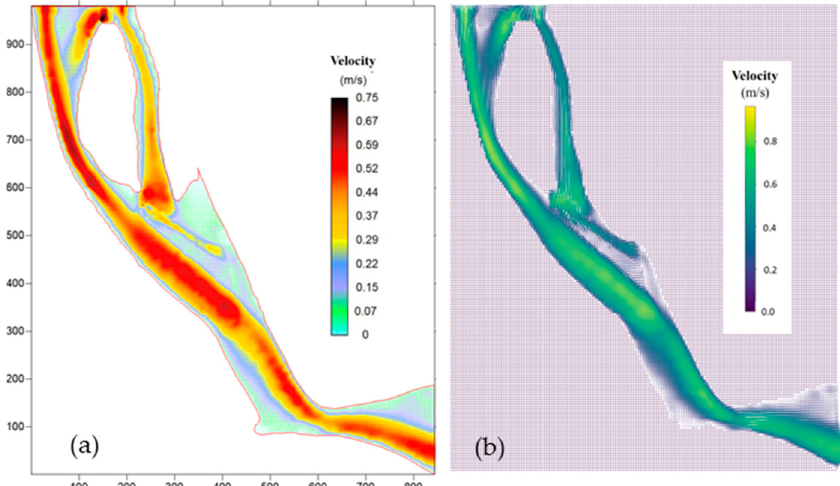
Figure 10. A visual comparison of the vector fields on the CPU (rendered using Surfer) ( a ) and on the GPU (rendered using Python) ( b ) after 15 h of simulation using 10 m-grid data.